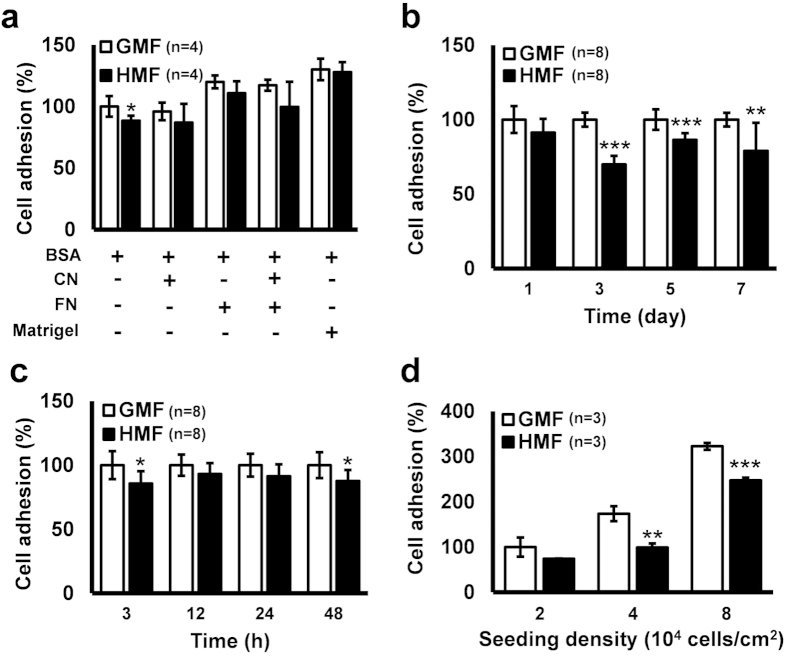
Decreased cell adhesion in the HMF.(a) After 7-day HMF or GMF pre-incubation, SH-SY5Y cells were allowed to adhere to wells pre-coated with human Collagen IV (CN; 40 μg/ml), human Fibronectin (FN; 40 μg/ml), 1:1 FN (20 μg/ml) and CN (20 μg/ml) mixture, 1:100 diluted Matrigel, or blank wells pre-coated with BSA (50 mg/ml). The cell adhesion assay showed that, in the blank wells, the percentage of adhesion of the cells exposed to the HMF was significantly lower than the GMF control. (b) The HMF exposure gradually reduced cell adhesive capacity. The adhesive capacities of day 1, day 3, day 5 and day 7 HMF-exposed cells were significantly reduced. (c) During 2-day HMF incubation, the adhesive capacity was reduced at 3 h and 48 h but maintained unchanged at 12 h and 24 h. (d) Cells from GMF condition were seeded in BSA coated blank wells at different densities and transferred to the HMF or GMF for a 3 h, short-term exposure. The adhesion ratios of the cells exposed to the HMF were significantly lower than the GMF controls at 4.0 × 104 cells/cm2 and 8.0 × 104 cells/cm2. n is the number of separate experiments. Data are shown as mean ± s.d. The P values were calculated using one-way ANOVA. *P < 0.05, **P < 0.01, ***P < 0.001.